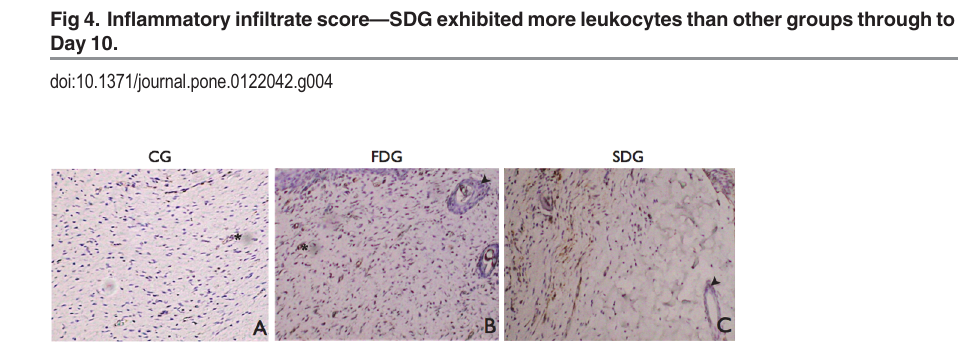
Fig 5. Immunohistochemical analysis with anti- α smooth muscle actin; myofibroblasts within granulation tissue stained brown; arrow heads point to smooth muscle in hair follicles; asterisks indicate smooth muscle in arterioles used as internal positive control of reaction; immunohistochemistry with DAB; original magnification: 400 x